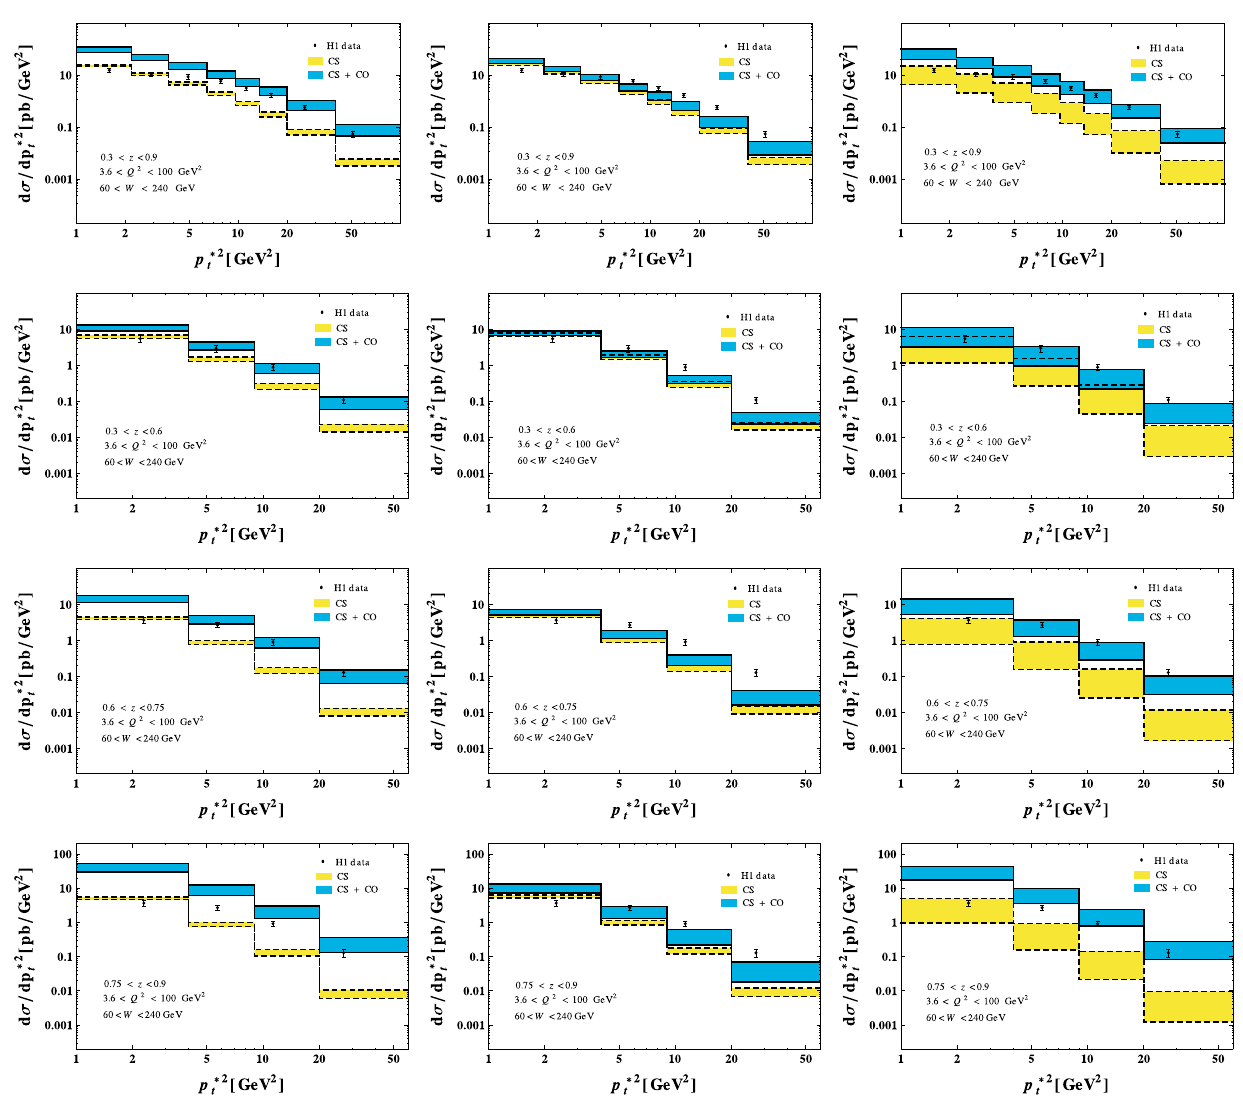
Fig. 5 The differential cross sections for the J /ψ production in DIS with respect to p (cid:11) 2 t . The experimental data are taken from Ref. [50]. The l.h.s., middle, and r.h.s. plots correspond to the LDMEs taken in Refs. [28,30,41],